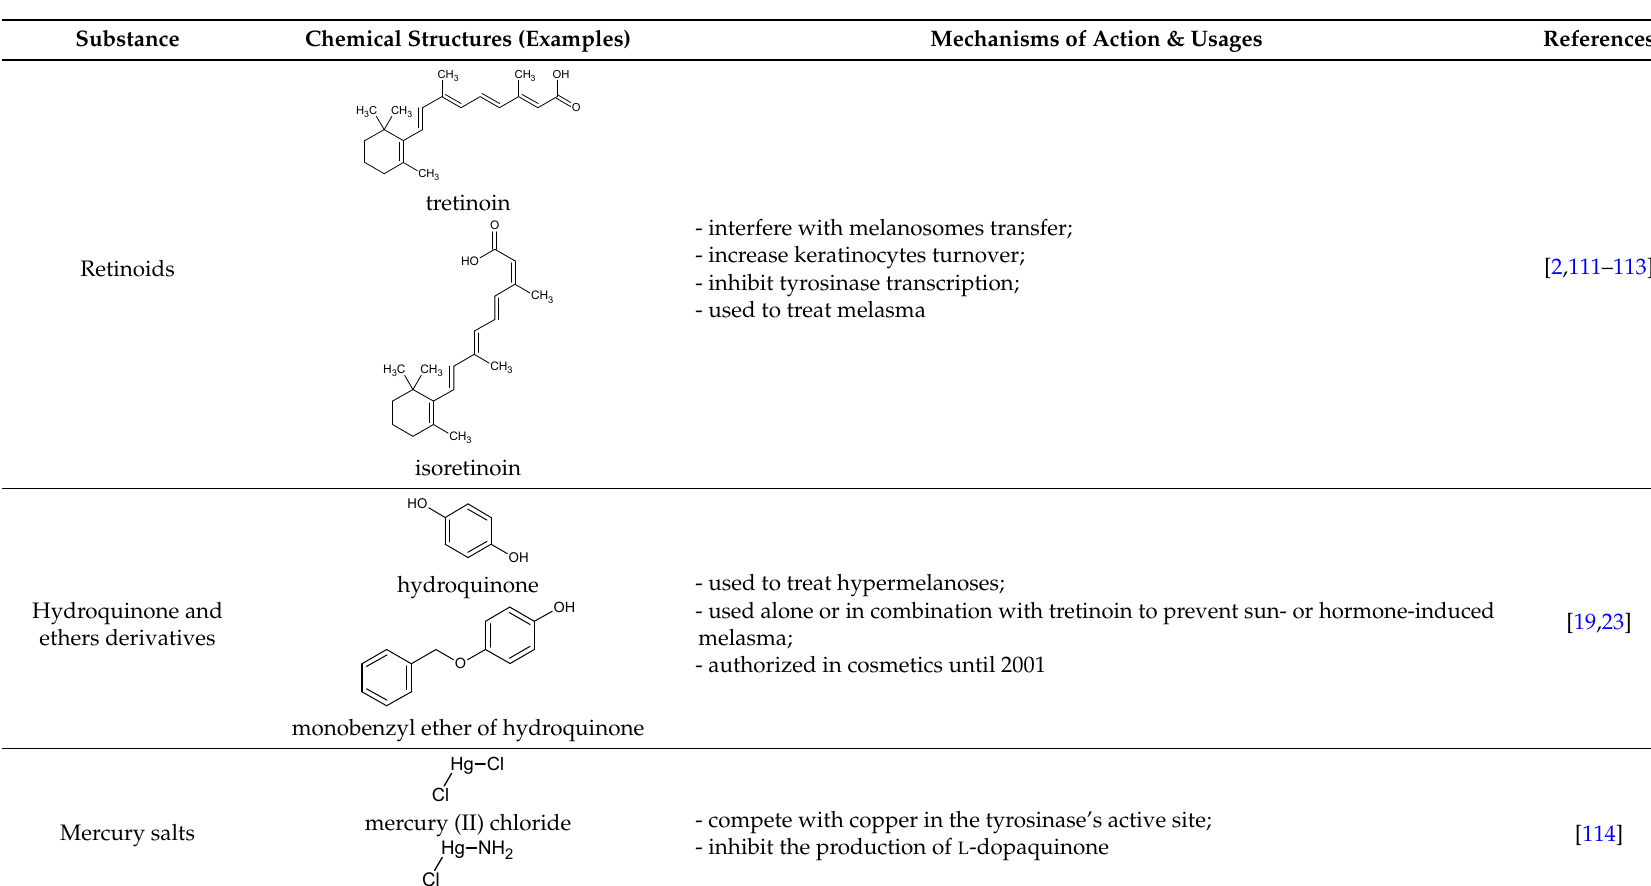
Table 1. Chemical structures and modes of action of the main skin-whitening substances traditionally used in whitening cosmetics. Substance